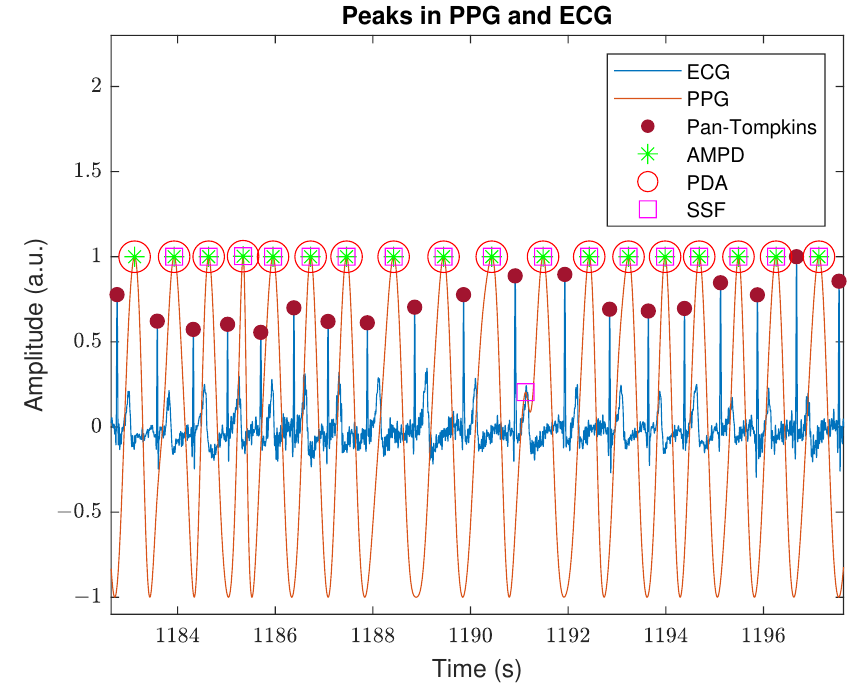
Figure 5. Visualization of peak detection in ECG and PPG signals. The Arm experiment, person